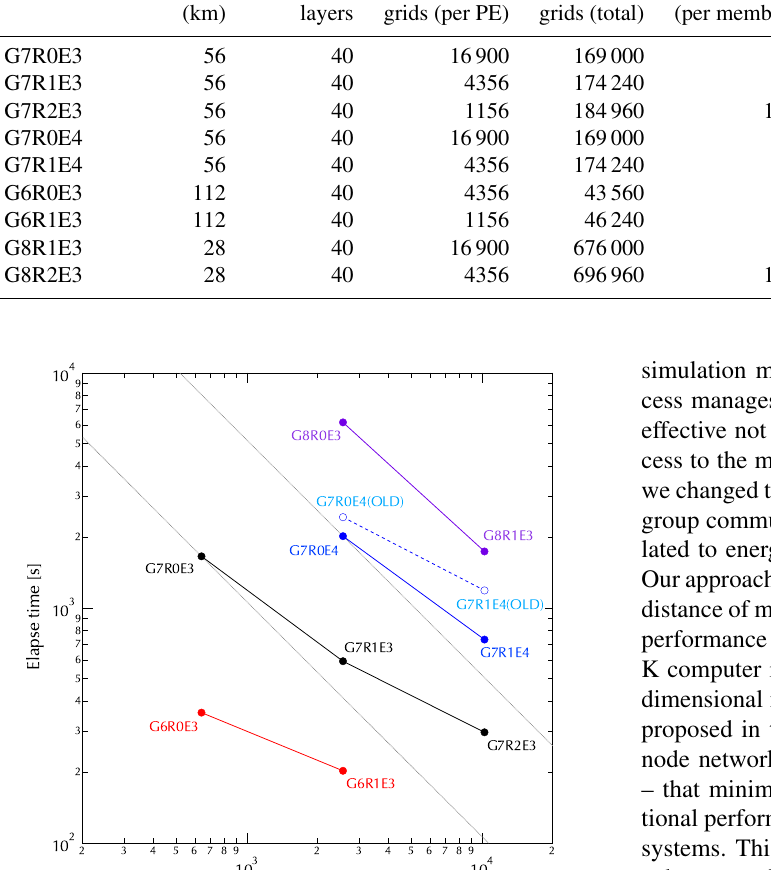
Table 1. Configurations of the DA experiment used to measure time taken on the K computer. PE means individual MPI processes. Exp. name